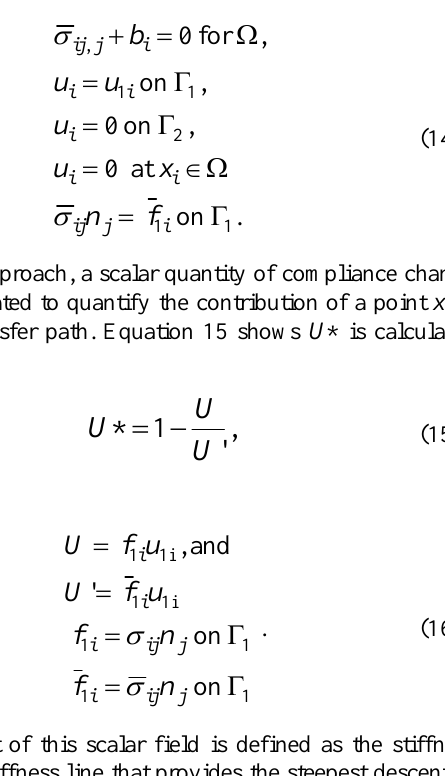
Fig. 10. Schematic of procedure for calculating U * where the loads flow. No trajectories can be traced from